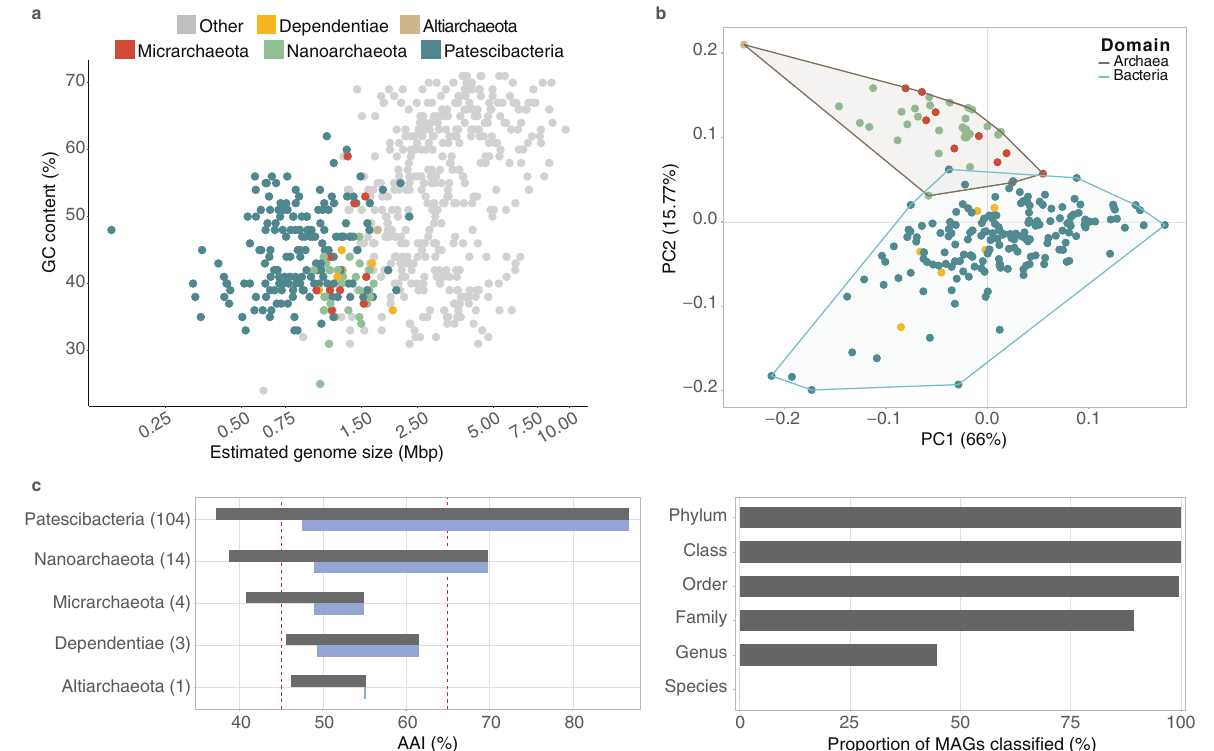
Fig. 3 Estimated genome size, metabolic content and novelty of groundwater ultra-small prokaryotes. a Estimated genome size of groundwater MAGs calculated as (bin size – (bin size * contamination)) / (completeness), as described by Castelle et al. [9]. Genomes of ultra- small prokaryotes are colored by phylum-level. Other microbial genomes are shown in grey. b Principal Component Analysis (PCA) based on the composition of COG metabolic categories in recovered ultra-small MAGs. c (Right) Range of all pairwise AAI values (grey) and maximum AAI values (blue) between ultra-small prokaryote MAGs recovered in this study and GTDB representative genomes for a given phylum. Red dashed lines represent the AAI range de fi ning the same family of organisms (45 – 65%) [74]. The number of genomes included in this analysis is indicated for each phylum in brackets. (Left) Proportion of ultra-small prokaryotic MAGs reconstructed in this study classi fi ed at each taxonomic level using